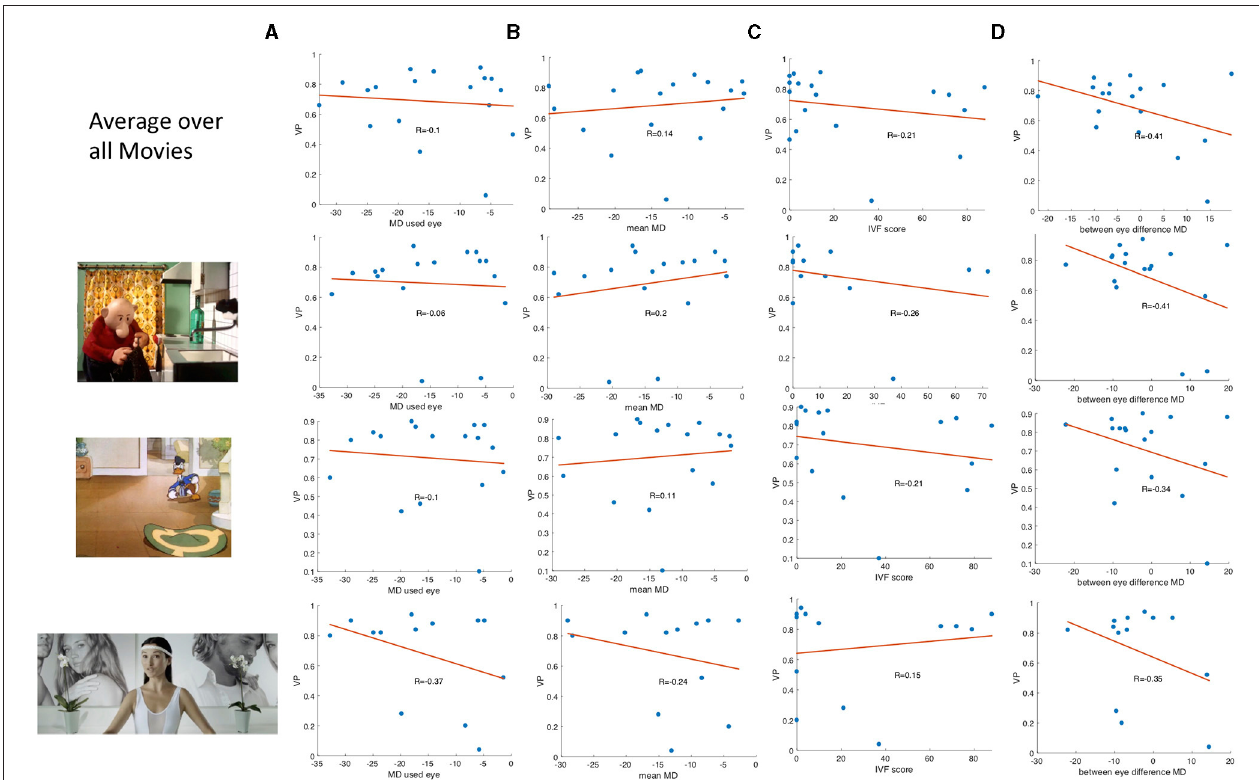
FIGURE 4 | Boxplots showing (A) the correlation between the VP value and the MD value of the measured eye of the participants with VFD, (B) the correlation of the IVF score and the VP, and (C,D) the correlation of the difference between the MD value of the measure.